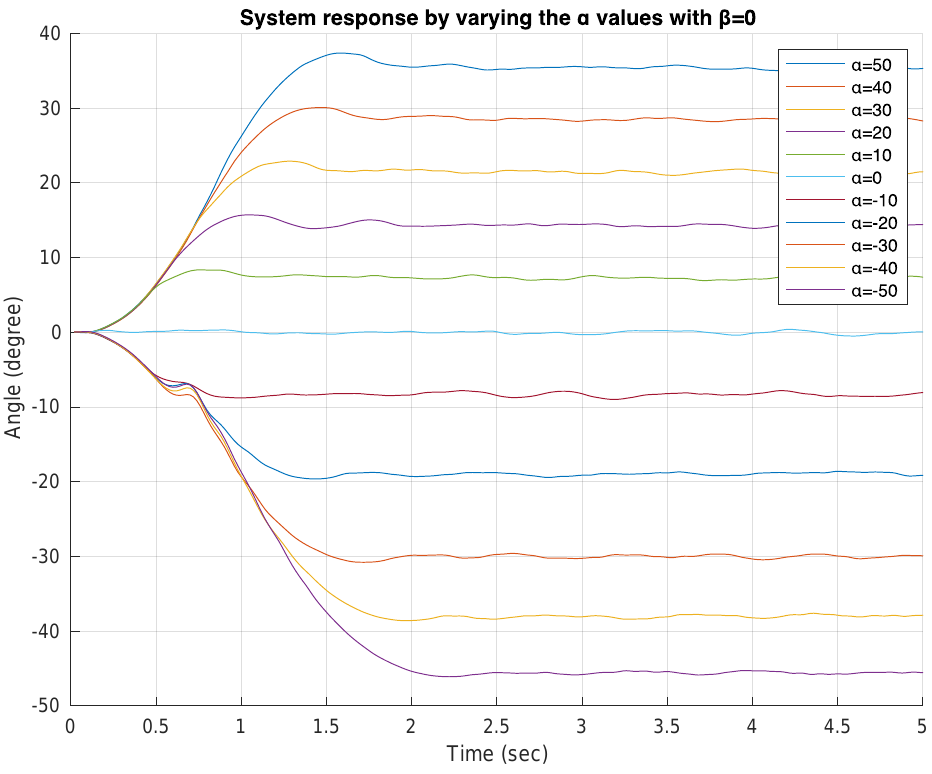
Figure 5. Identification data using motor position input and pitch output. Step references for α within the range [ − 50,50] in steps of 10 degrees with a random ± 1 noise and with constant β = 0 have been used. It can be seen that the pitch position reached in time is different for positive and negative